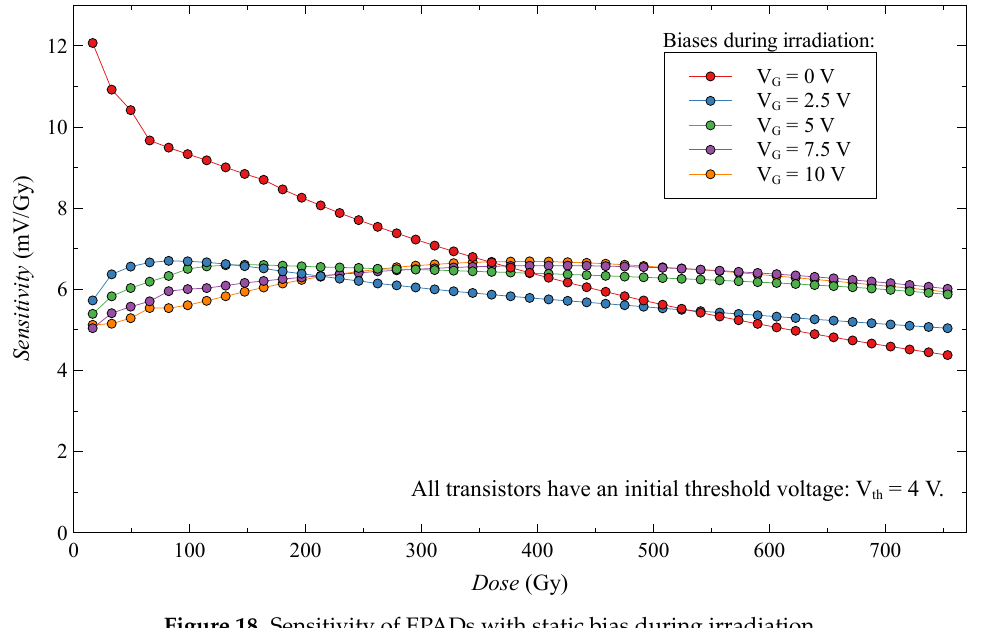
Figure 18. Sensitivity of EPADs with static bias during irradiation.